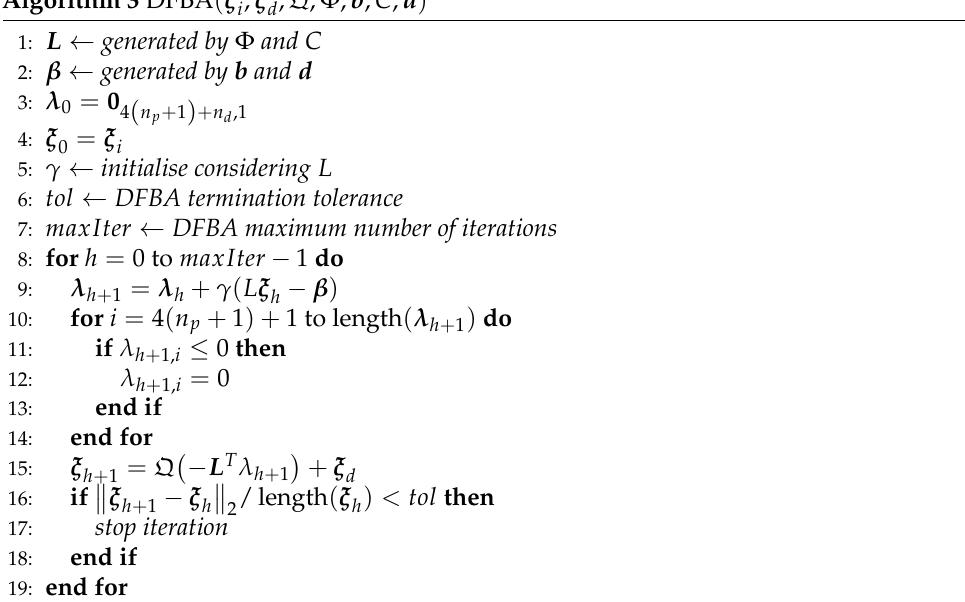
Algorithm 3 DFBA ( ξ